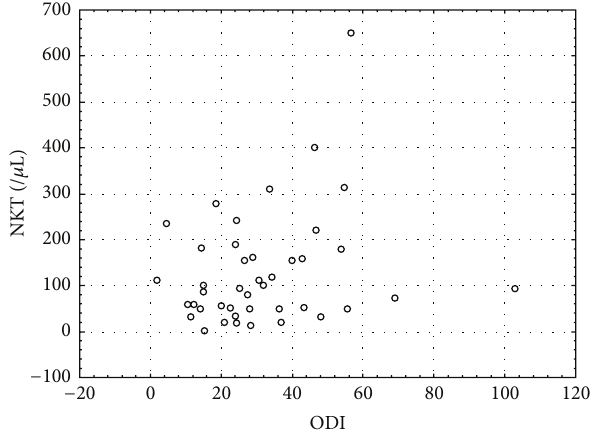
Figure3:Significantcorrelationbetweenoxygendesaturationindex (ODI) and the number of NKT-like cells in the peripheral blood of OSA patients ( 𝑟 = 0.4 , 𝑝 < 0.05 ).